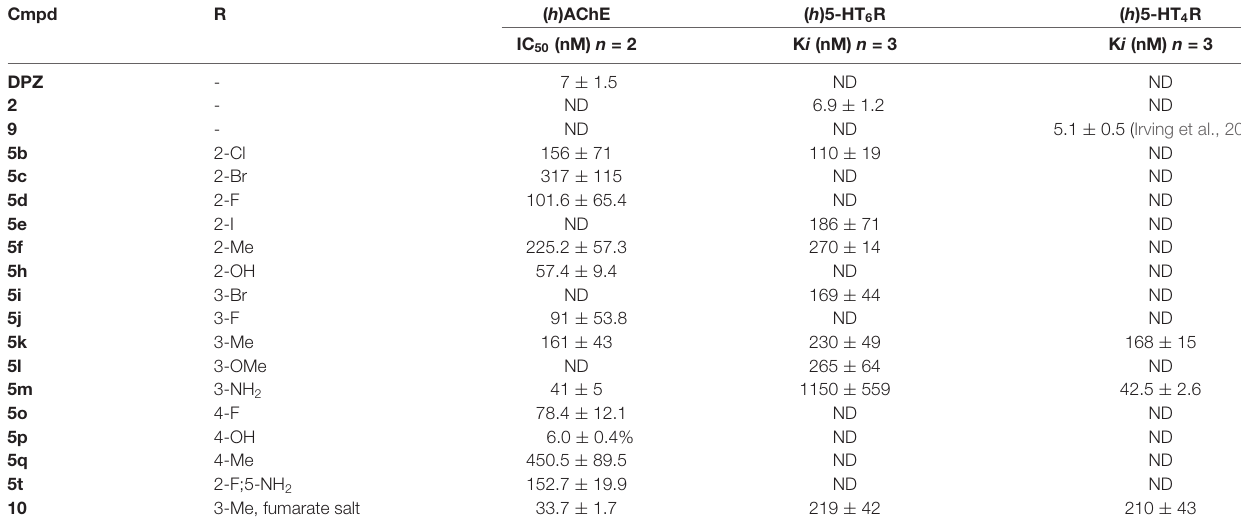
TABLE 2 | ( h )AChE inhibitory activity (IC 50 ) and ( h )5-HT 6 R and ( h )5-HT 4 R affinity (K i ) for DPZ, 2 , 9 , 5b–f, h–m, o–q, t and the fumarate 10 .